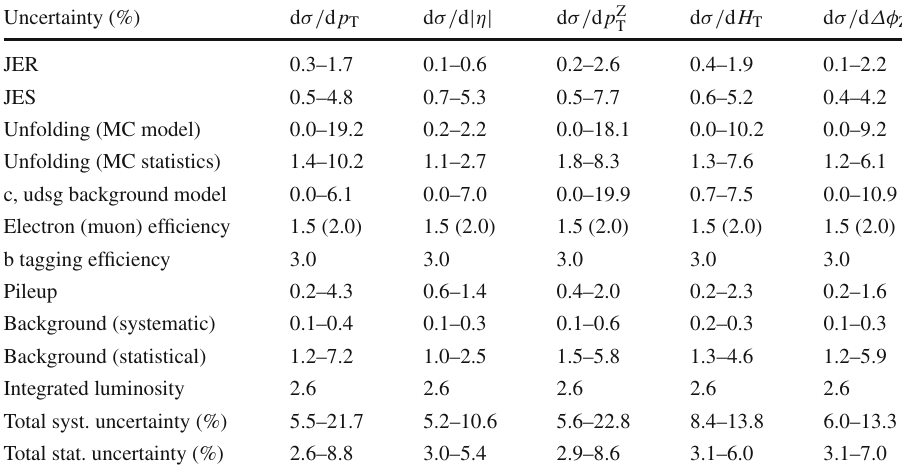
Table 2 Uncertainties (in percent) in the differential cross sections as a function of the leading b jet p T and | η | , the Z boson p T , H T , and Δφ Zb between the Z boson and the leading b jet, for the Z ( 1b )